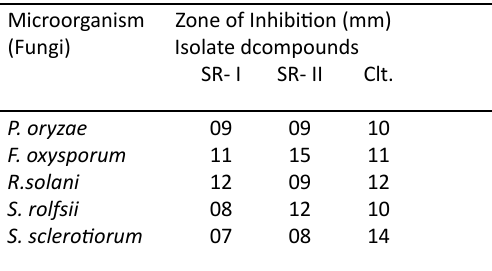
Table 3. Antifungal screening of isolated compounds Microorganism Zone of Inhibition (mm) Isolate